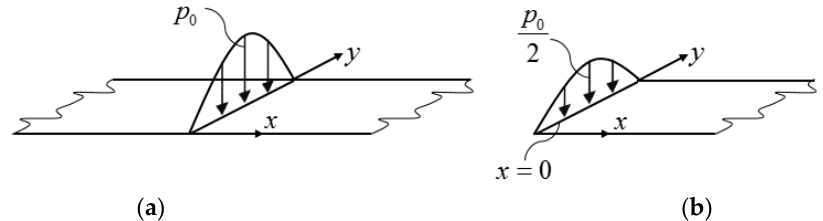
Figure 3. Long plate subjected to a trigonometrical line load ( a ) and the corresponding half plate ( b ).